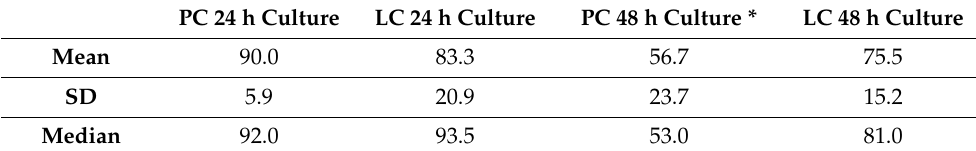
Table 2. Post-thaw cell viability (%) after 24 and 48 h of culture–slow thawing protocol.